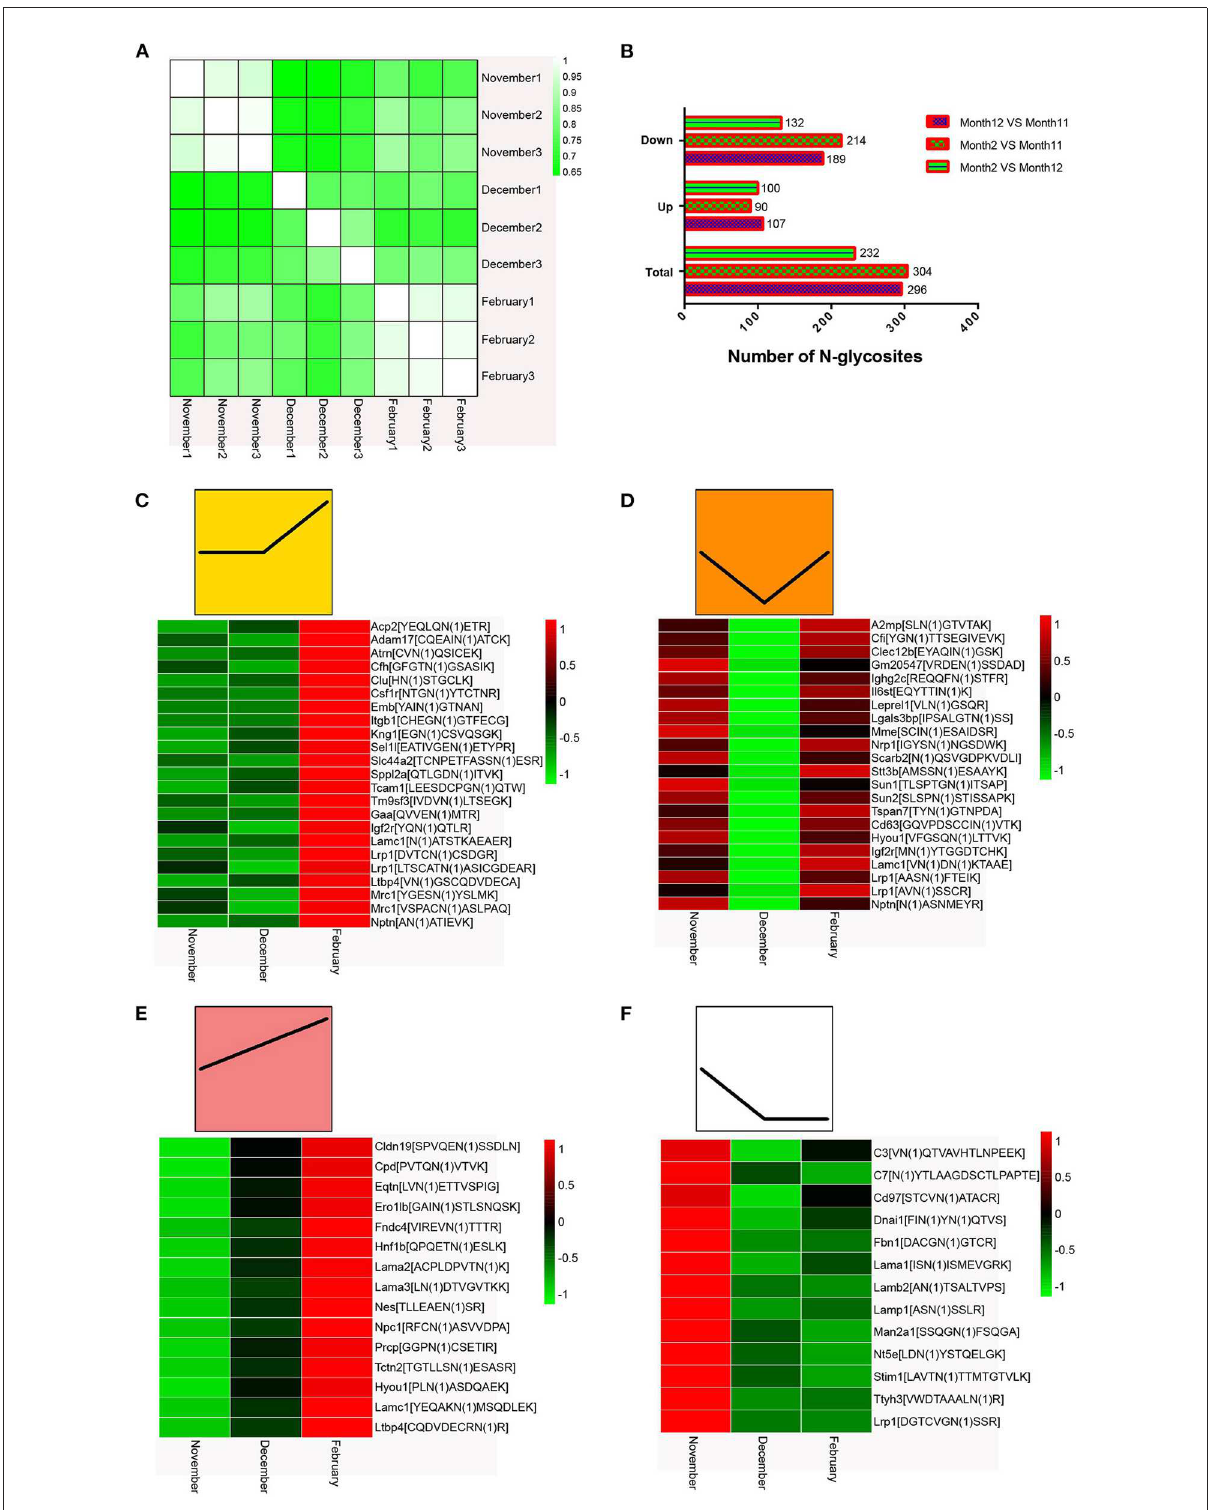
FIGURE4 (A) Quantified repeatability of three biological repeats. (B) Changes in N-glycosidic peptides at different times after normalization of protein abundance. (C–F) Heat map of N-glycosylation sites in mink testis proteins ( p < 0.05). Bar color represent a logarithmic scale from − 1 to 1. Each column indicates a group and each row represents an N-glycosylation